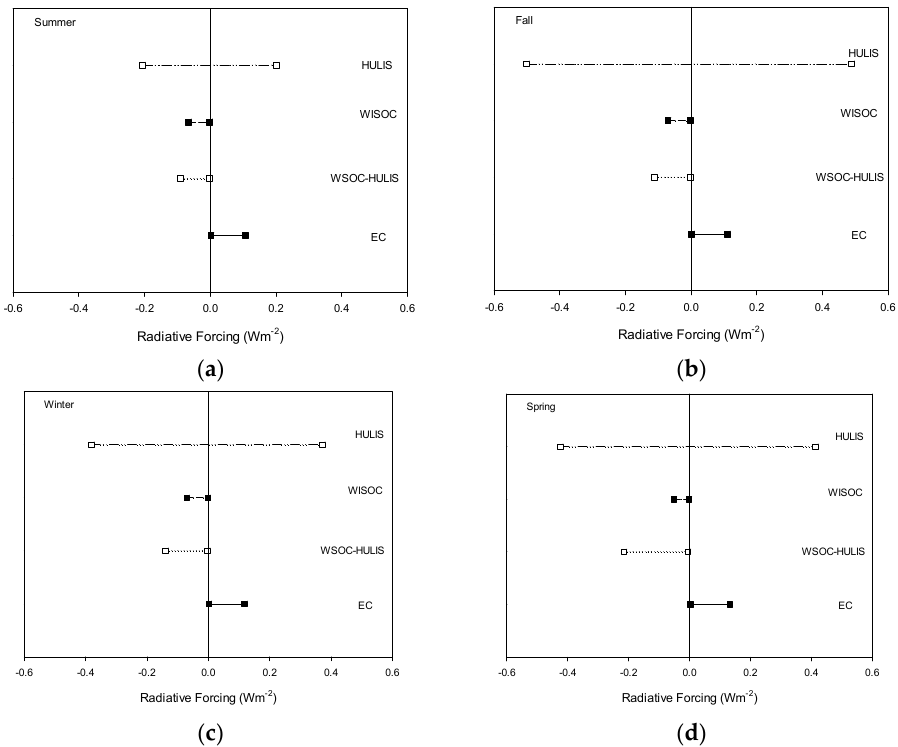
Figure 5. Seasonal variation of RF (Radiative Forcing) for each carbonaceous aerosol (0.1 µm < d g < 1.0 µm, 1.1 < σ g < 2.0, 0.006 < HULIS IRI < 0.3) in ( a ) summer; ( b ) fall; ( c ) winter; and ( d ) spring.